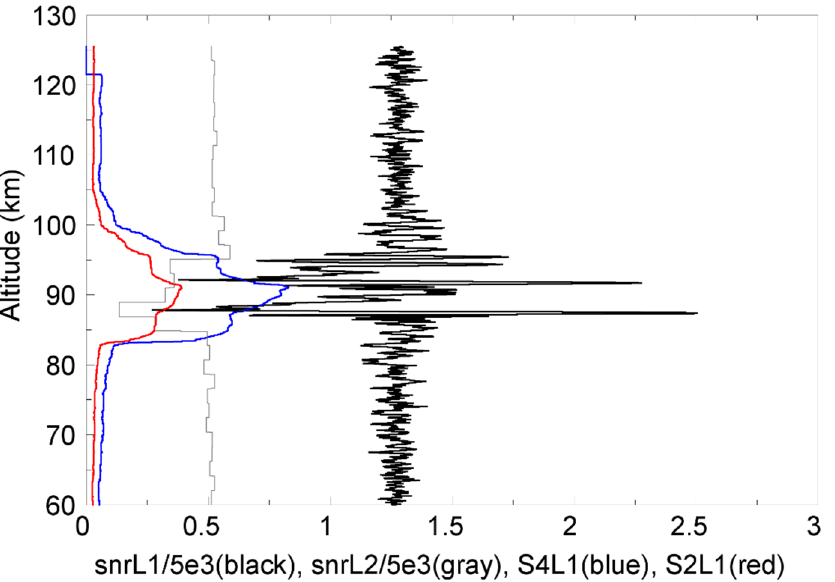
Figure 4. One example of FS3/COSMIC GPS RO observation with an Es event. The limb viewing L1- and L2-band SNR amplitudes of 50 Hz data versus GPS-LEO tangent point altitudes are shown in black and gray, respectively. The resulting S 4 and S 2 altitudinal profiles of GPS L1-band signals are also shown in blue and red, respectively. Notably, the peak S 4 ( S 2 ) value is 0.82